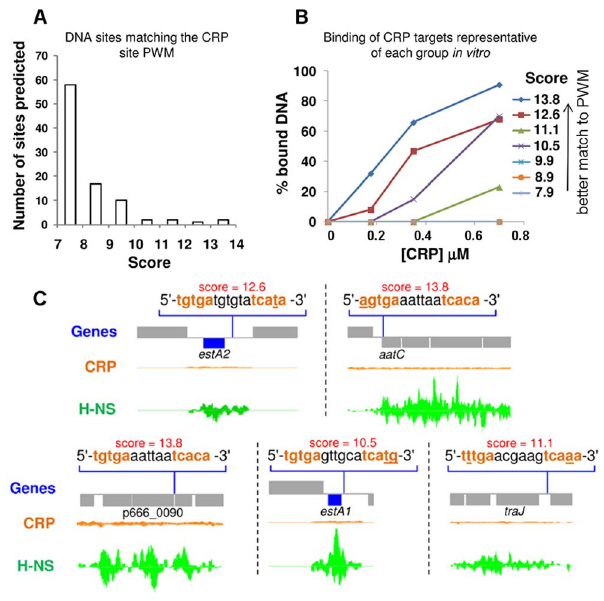
Fig. 2. Unoccupied CRP sites on p666 and p948 align with H-NS bound regions. A) A histogram showing the number of putative CRP binding sites in each of 7 discrete bins. Each bin is delineated by the ‘‘score’’ of the putative CRP site. A high score indicates a better match to the Position Weight Matrix that represents the consensus for CRP binding. B) The graph illustrates binding of CRP to a target from each of the bins shown in Panel A. CRP was used at concentrations of 0, 175, 350 or 700 nM. C) ChIP-seq data for CRP and H-NS binding at five regions of plasmids p666 and p948 that contain unoccupied CRP targets bound by CRP in vitro . The CRP and H-NS binding profiles are plots of sequence read counts at each position of the genome on both the top (above the central line) and bottom (below the central line) strand of the DNA. The y-axis scale is the same in each panel. The scale for H-NS binding is 1,785 reads on each strand and for CRP binding is 14,000 reads on each strand.